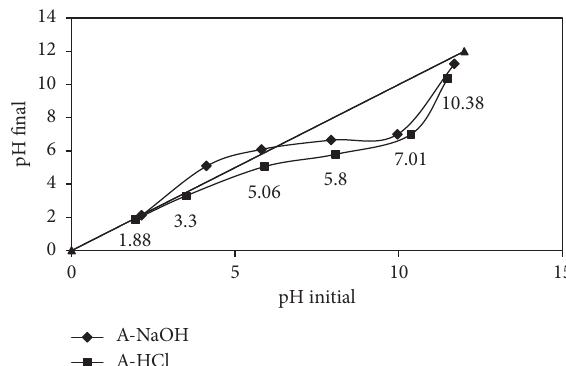
Figure 1: Point of zero charge acacia sawdust A-HCl and